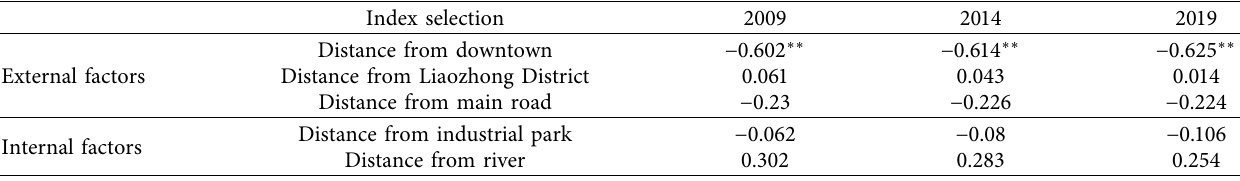
Table 9: Correlation analyses of land-use change from 2009 ‒ 2019 in Ciyutuo